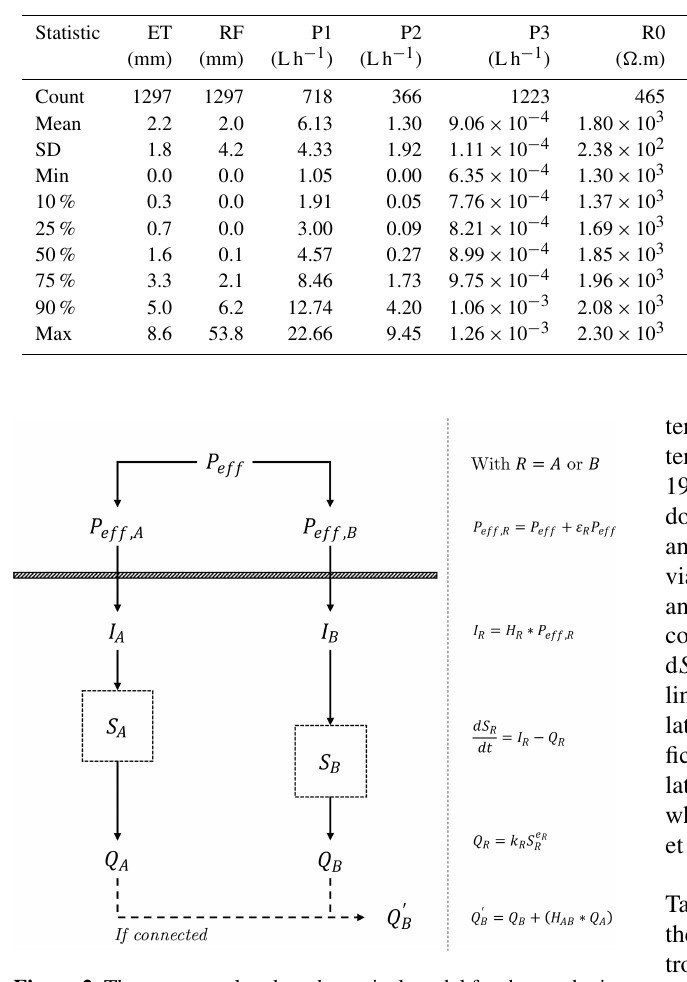
Figure 2. The conceptual and mathematical model for the synthetic case study. Two reservoirs A and B are forced by inflows I A or I B resulting from the unit hydrograph H A and H B forward convolution on noisy variants P eff , A and P eff , B of the same effective precipita- tion P eff computed from real data (Sect. 2.2). The storage S A and S B dynamics follows a typical continuity equation d S/ d t = I − Q , where the discharges Q A and Q B follow a nonlinear power law Q = kS e with two parameters k and e . Reservoir B responds mainly 1d after A, which introduced a systematic time dependency be- tween the reservoir suggesting causation. Q (cid:48) is a flow downstream B of Q B draining Q A and transferred considering the unit hydrograph H AB . The causal analysis involves either the disconnected case Q A and Q B or the connected case Q A and Q (cid:48) . Multivariate methods B include P eff within the